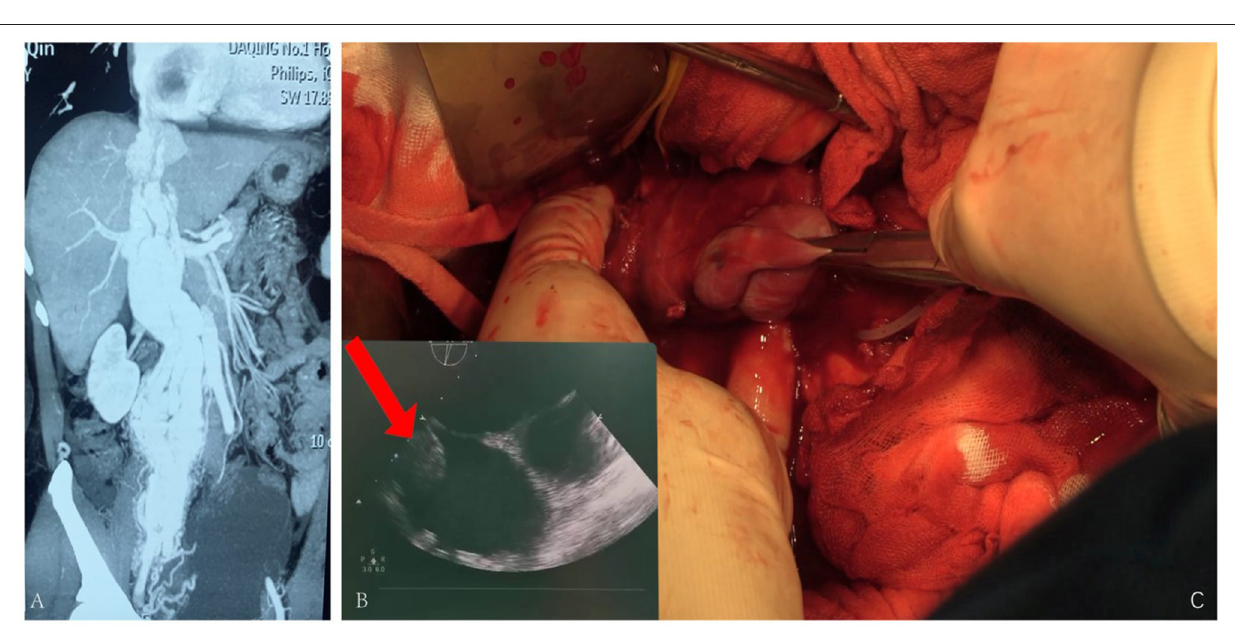
AVF, which was not associated with IVL. Besides, the IVL was complicated by intracardiac extension. During the surgery, bleeding was hard to control due to the high venous return from